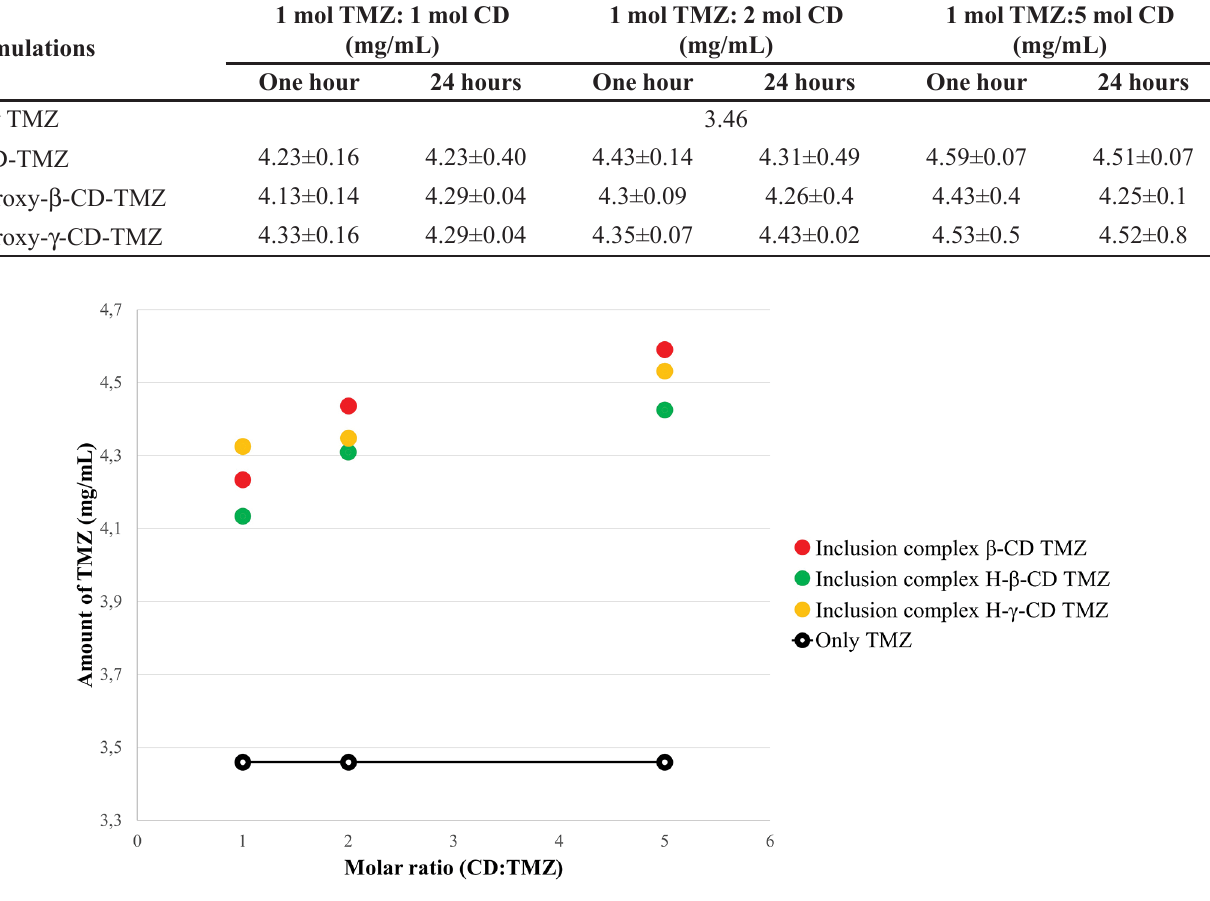
FIGURE 9 - Amount of solubilized TMZ in mg/mL in 0.1 M HCl after the formation of inclusion complex after one